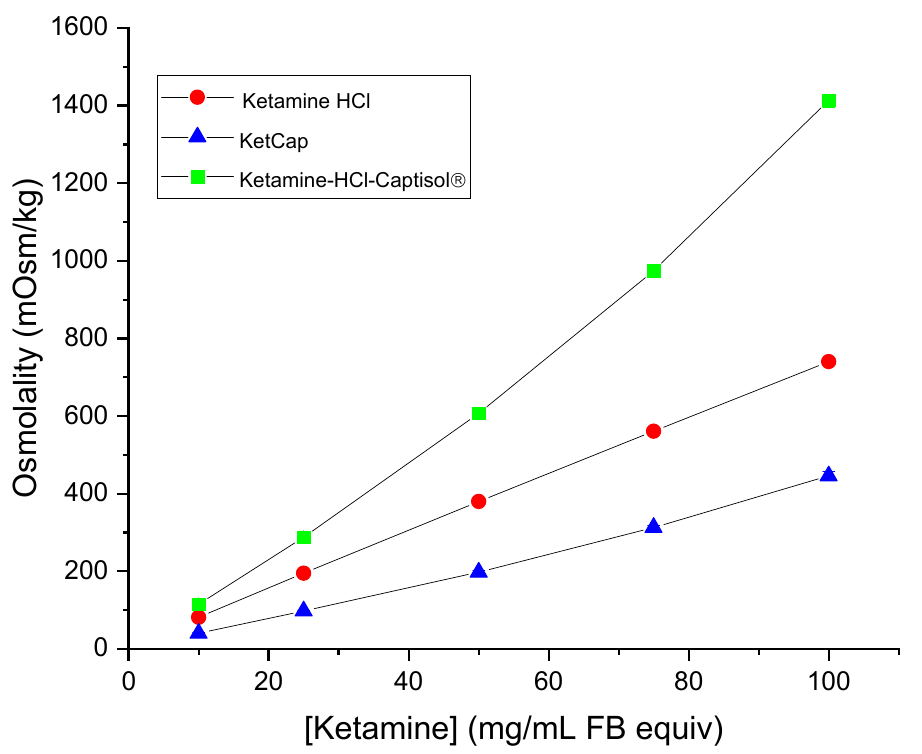
Figure 2. Dilution vs. osmolality of Ketamine HCl and formulations. Measured osmolalities of Ketamine HCl, KetCap, and Ketamine-HCl-Captisol ® at different concentrations obtained following dilution of 100 mg/mL stock formulations. Data presented as mean ± SEM. N = 3.